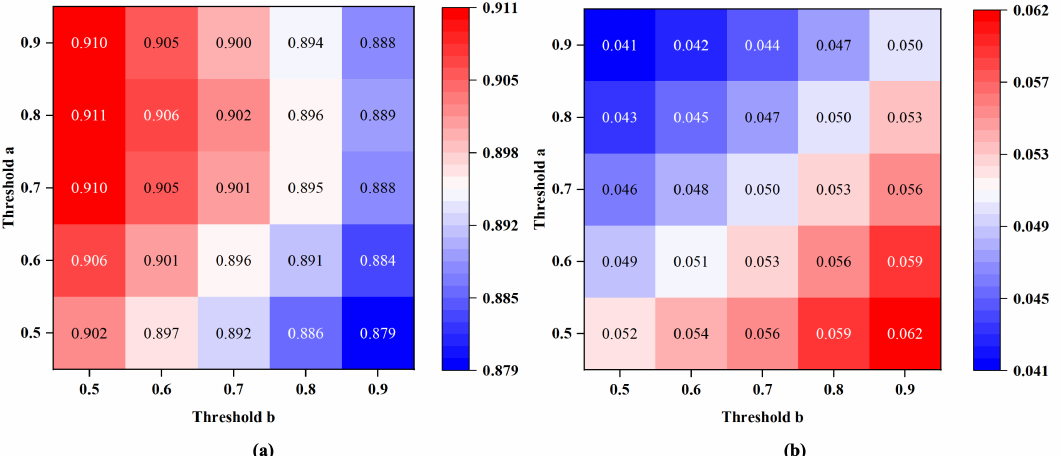
Figure 12. Comparison of 30-year average classification results after a temporal consistency correction under different classification probability combinations: ( a ) the average F1-score of the correction results, ( b ) the standard deviation of the F1-score of the correction results.